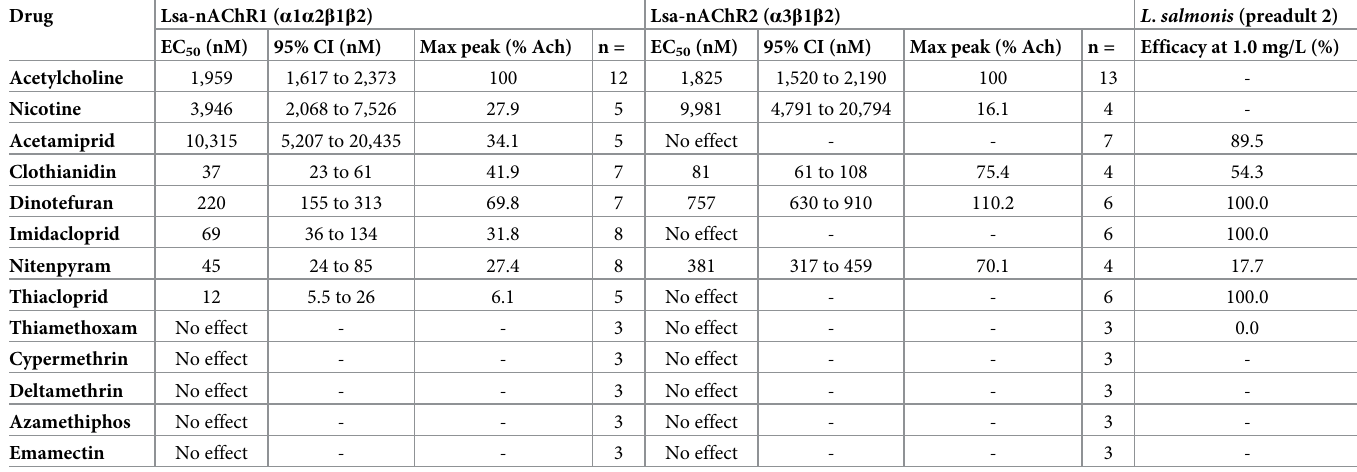
https://doi.org/10.1371/journal.ppat.1008715.t002